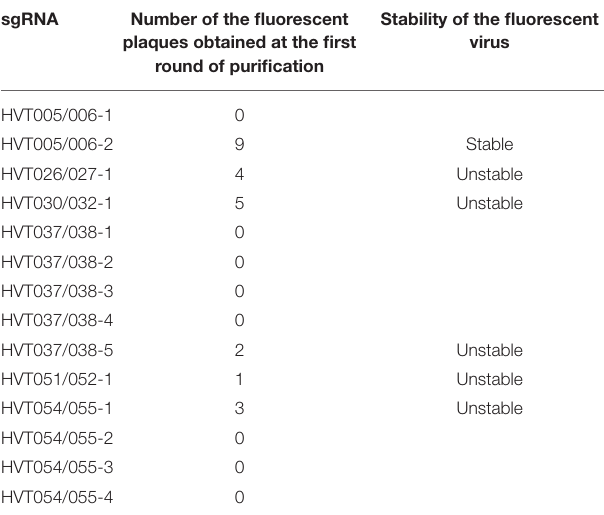
TABLE 4 | Screening results of the mCherry insertion sites in the UL region of HVT.